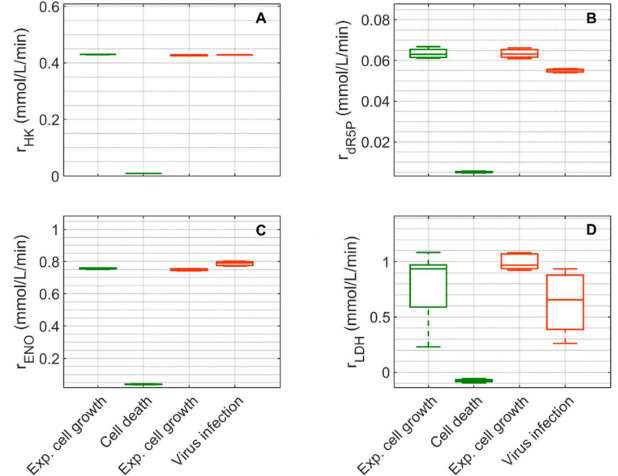
Figure 7. Box-and-whisker plot for selected intracellular rates of glycolysis and pentose phosphate pathway estimated from model simulations for mock-infected and infected suspension MDCK cells. ( A ) Hexokinase, ( B ) ribose-5-phosphate, ( C ) enolase, and ( D ) lactate dehydrogenase. Calculated from model simulations of the exponential growth phase of Cultivation 1 ( , 6–108 h), the death phase of Cultivation 1 ( , 146–169 h), the exponential growth phase of Cultivation 2 ( , 6–48 h) and the virus replication phase of Cultivation 2 ( , 49.9–107 h). The bar represents the median, the box is the first and third quartile, and the whisker the minimum and maximum of the rates from the model simulations of the corresponding cultivation phase.